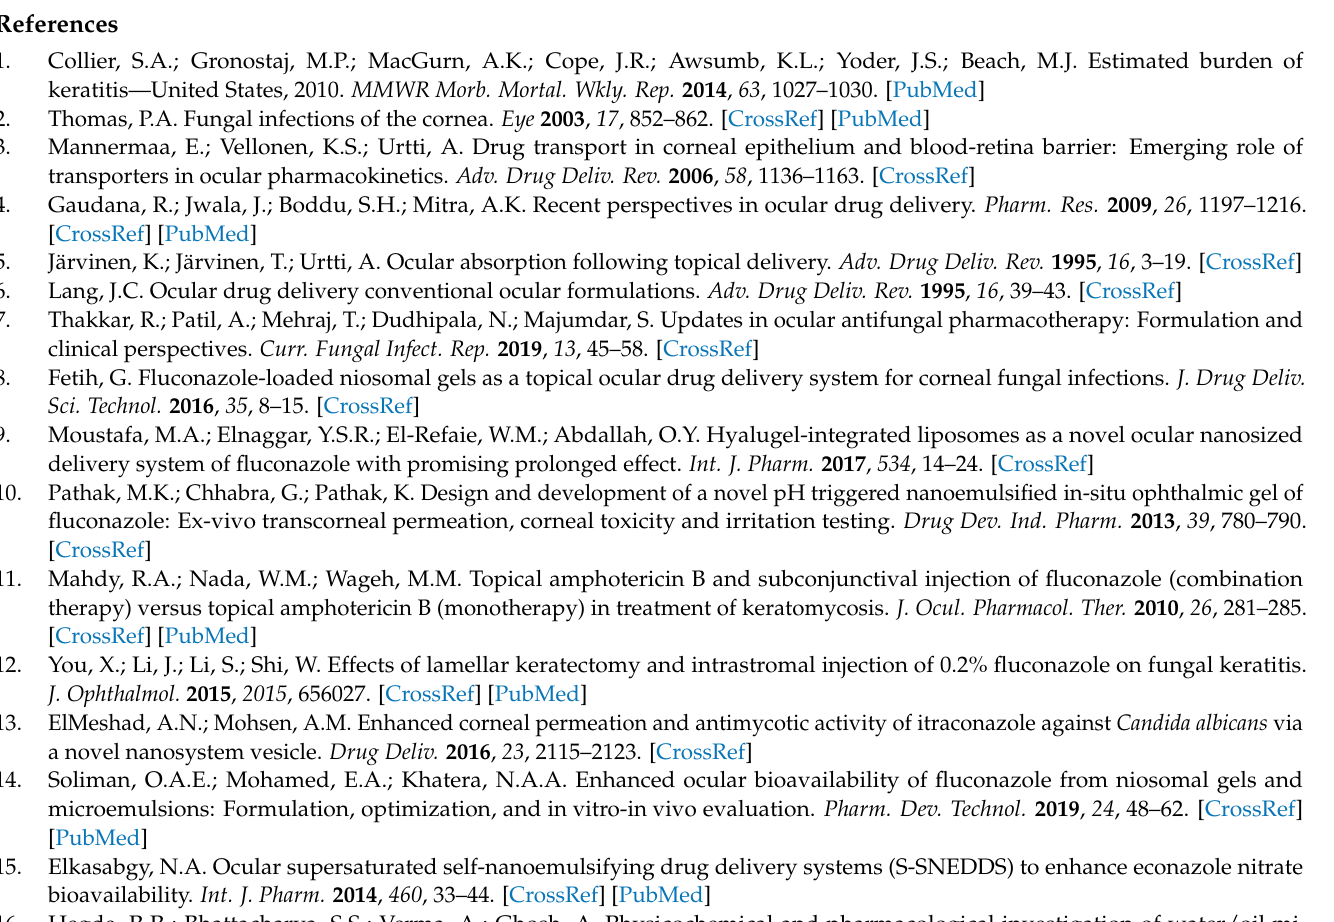
Table S3: ANOVA analysis of PDI (Y 2 ); Table S4: ANOVA analysis of drug content (Y 3 ); and Table S5: ANOVA analysis of % of permeation at 8 h (Y 4